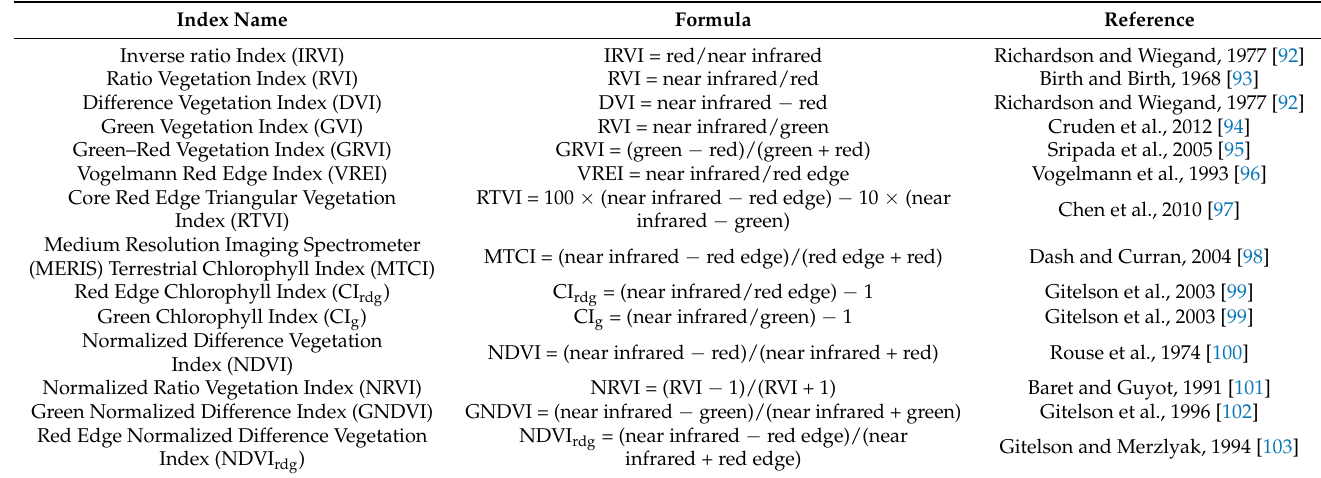
Table A1. The full name of individual vegetation indexes (VIs), their formula for calculation, and the reference of the